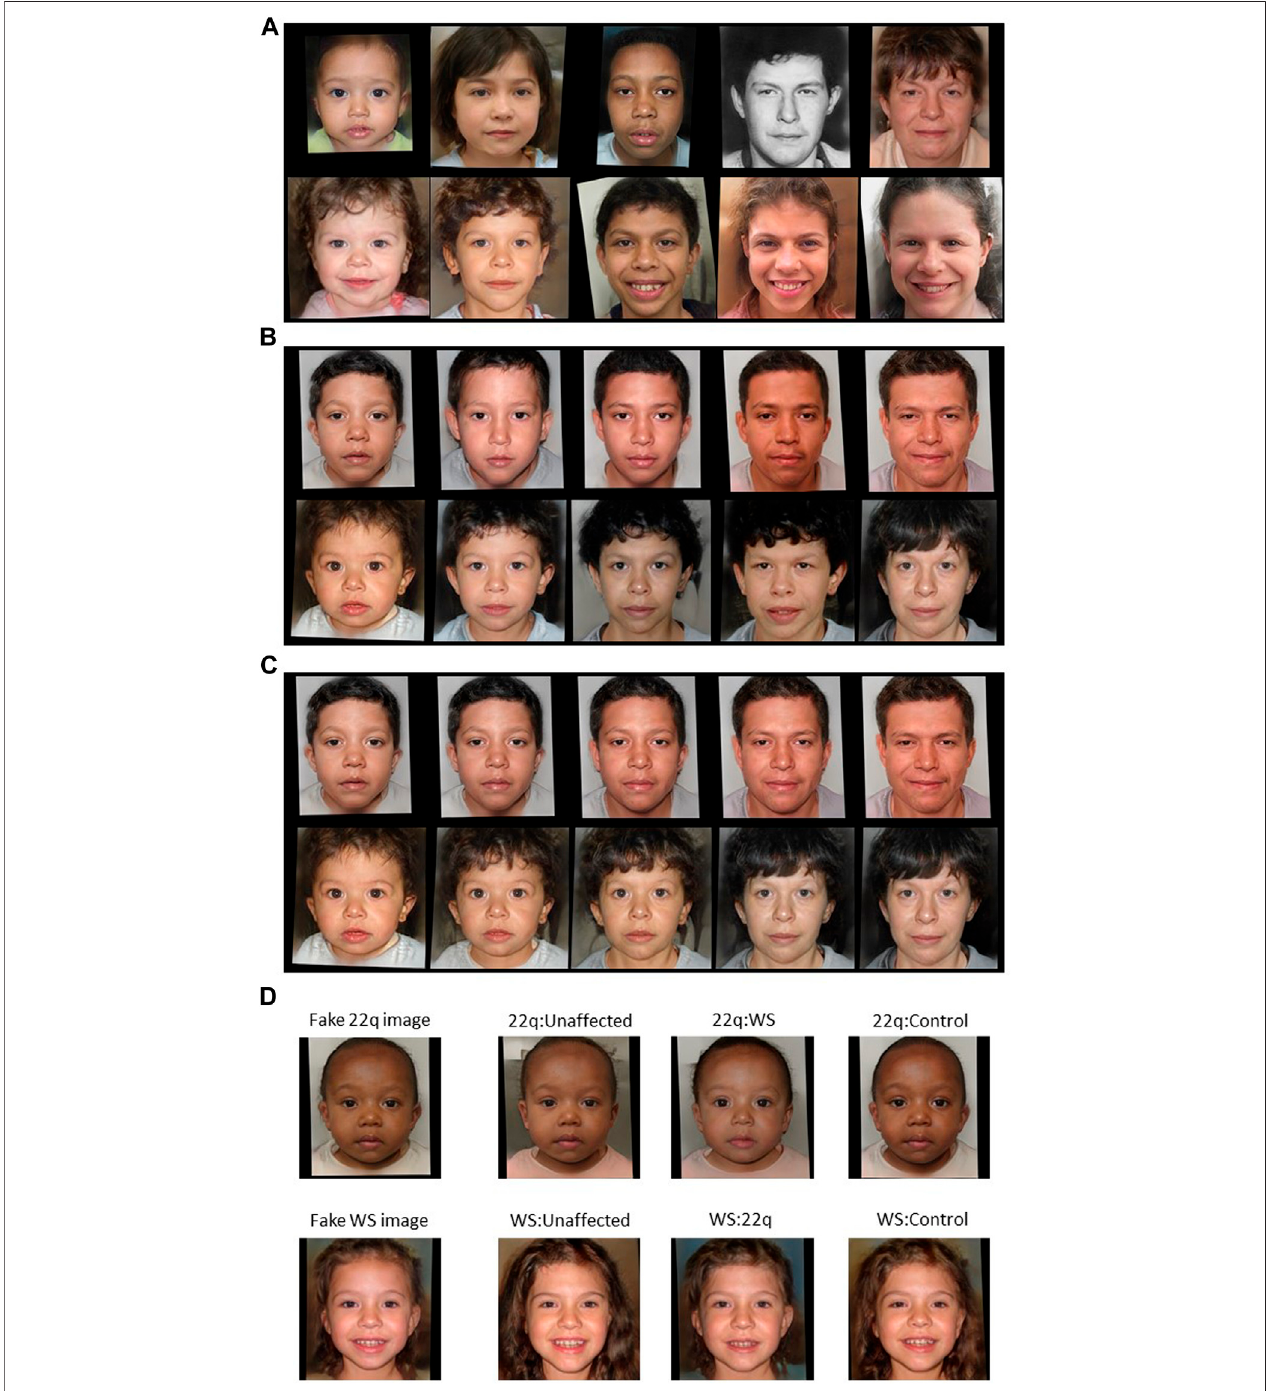
FIGURE 2 | Examples of GAN fake images for 22q and WS. Type 1 fake images of (A) 22q (top row) and WS (bottom row) were generated with GAN and are all theoreticallyunique.Fortype2fakeimages (B) of22q(toprow)andWS(bottomrow),generalfeatures,such asskin toneand haircolor,areroughlypreserved. Fortype 3 (C) ,thegeneratedimagesof22q(toprow)andWS(bottomrow)lookconsistentatdepictingthesame “ person ” progressingthroughdifferentagegroups.Type4fake images (D) werecreated withblended facial characteristics oftwodisease labels. The maindisease condition (22qorWS)represents55%ofthefacialphenotype, and the added disease condition represents 45% of the facial phenotype. For example, WS:unaffected is a blend of 55% WS facial features and 45% unaffected facial features. Only the blended images were used for training, and the left most images are shown here as references.